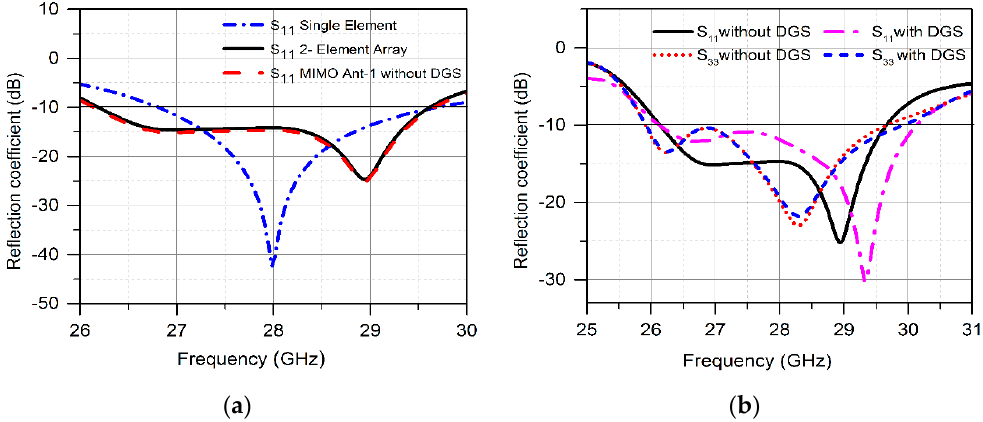
Figure 3. Simulated Reflection Coefficient of ( a ) Single Element, Two Element array, MIMO Ant1 ( b ) Reflection coefficient of MIMO Ant1 and Ant3 with and without DGS.